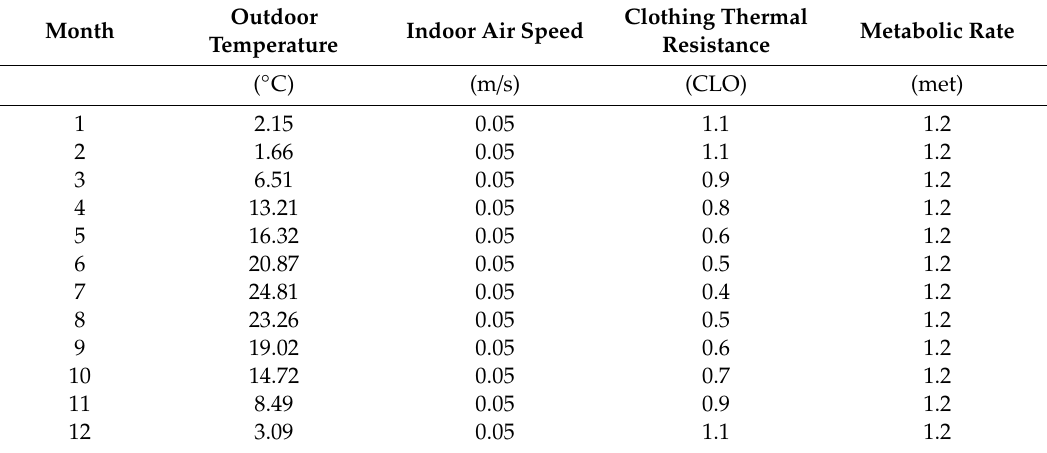
Table 2. Input parameters for thermal comfort